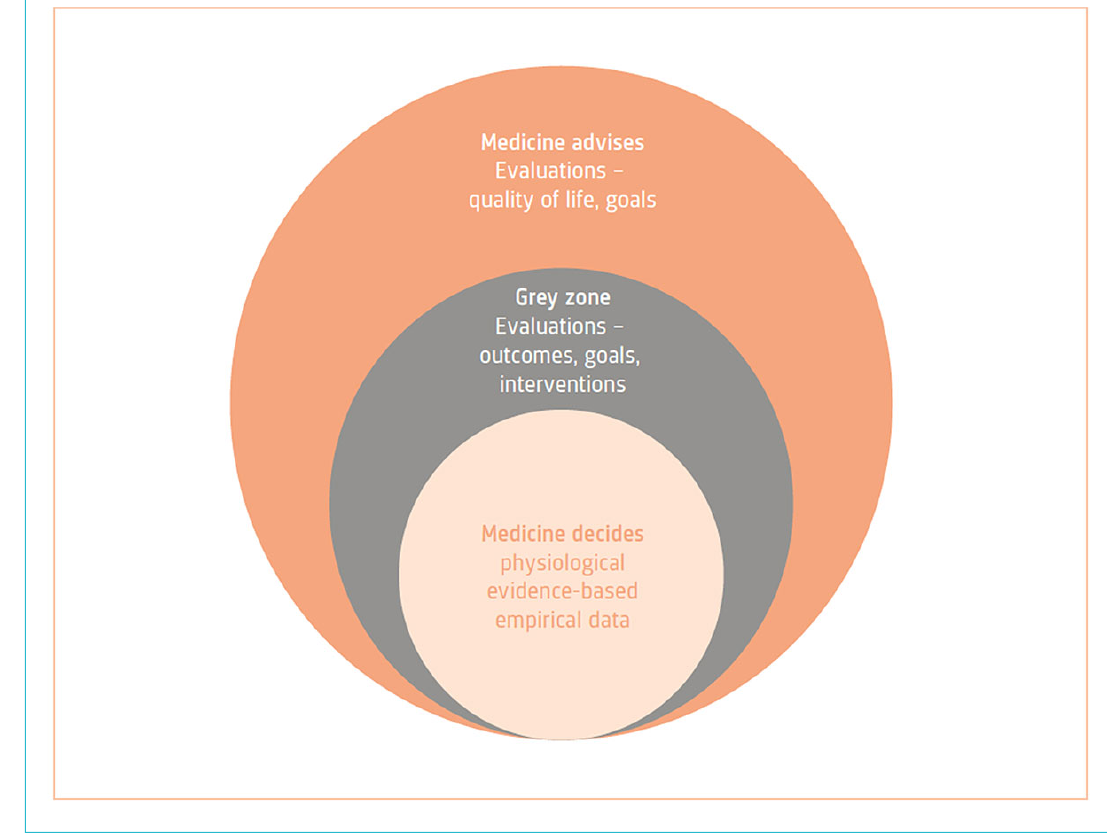
Figure 1: Futility and decision-making in medicine. While for a closely circumscribed set of medical interventions effectiveness can be clearly ruled out on the basis of physiological processes or empirical medical evidence and knowledge, a much larger area remains in which evaluations of effectiveness may vary according to the goal of treatment. Lying between these two areas is a “grey zone”, in which the ques- tion of what interventions are to be offered as therapeutic options needs to be negotiated in the specific social and economic